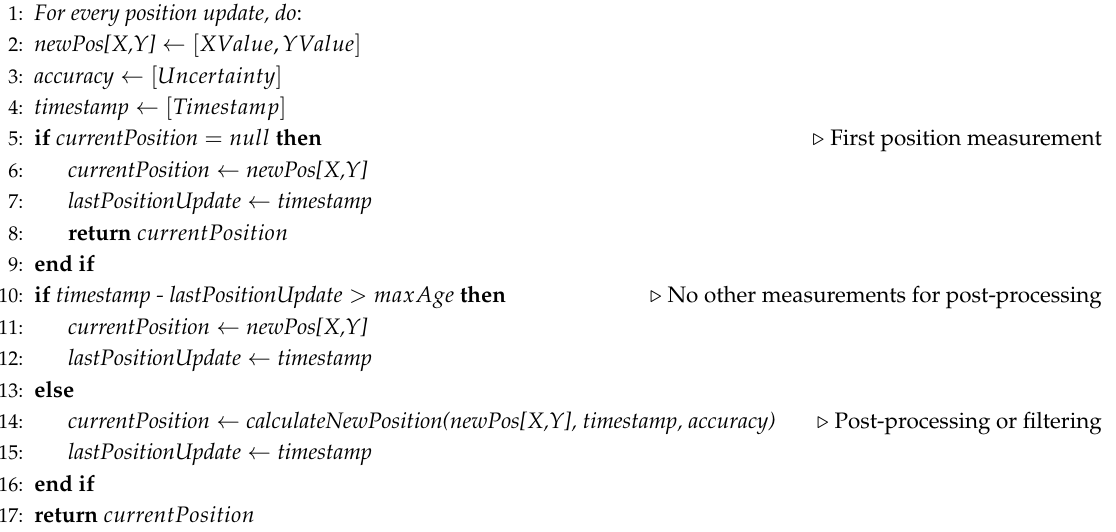
Algorithm 1 Localization calculation for a device with multiple localization